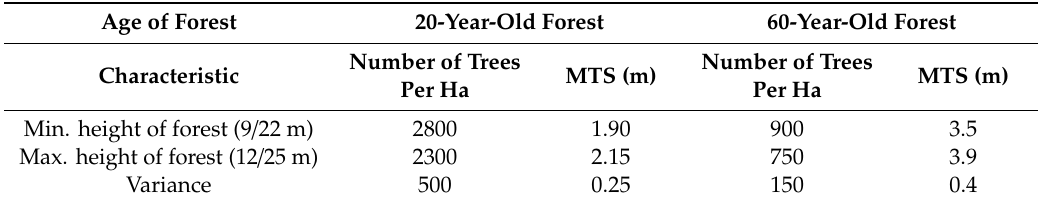
Table 2. Characteristics of 20-year-old and 60-year-old forest for 3-m variance of height of the forest (heights per age in parentheses). The prevailing age of trees in the studied areas is used from a growth table from Cerny, 1996